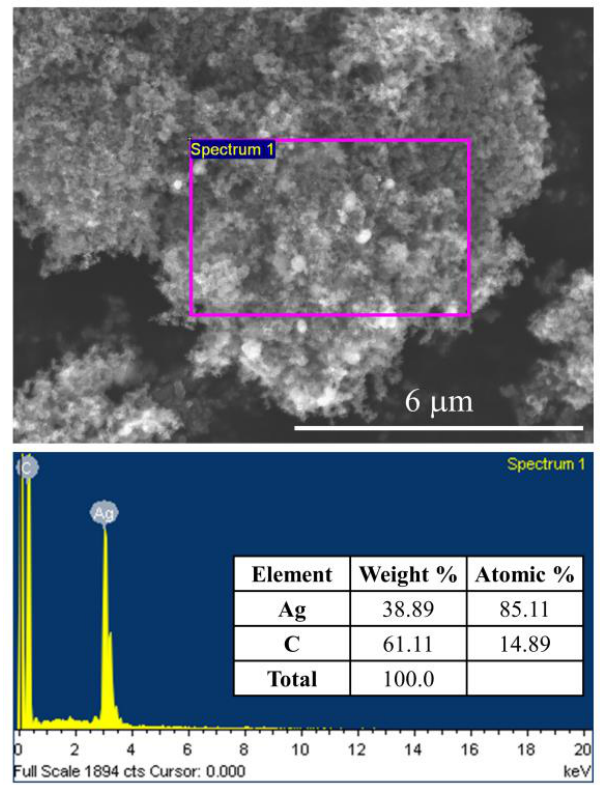
Figure 4. SEM images: ( a ) secondary electron image (SEI) and ( b ) composition (COMPO) mode for Ag/acetylene carbon (AC); ( c ) SEI and ( d ) COMPO mode for Ag/carbon black (CB); ( e ) SEI and ( f ) COMPO mode for Ag/multiwalled carbon nanotube (MWCNT).